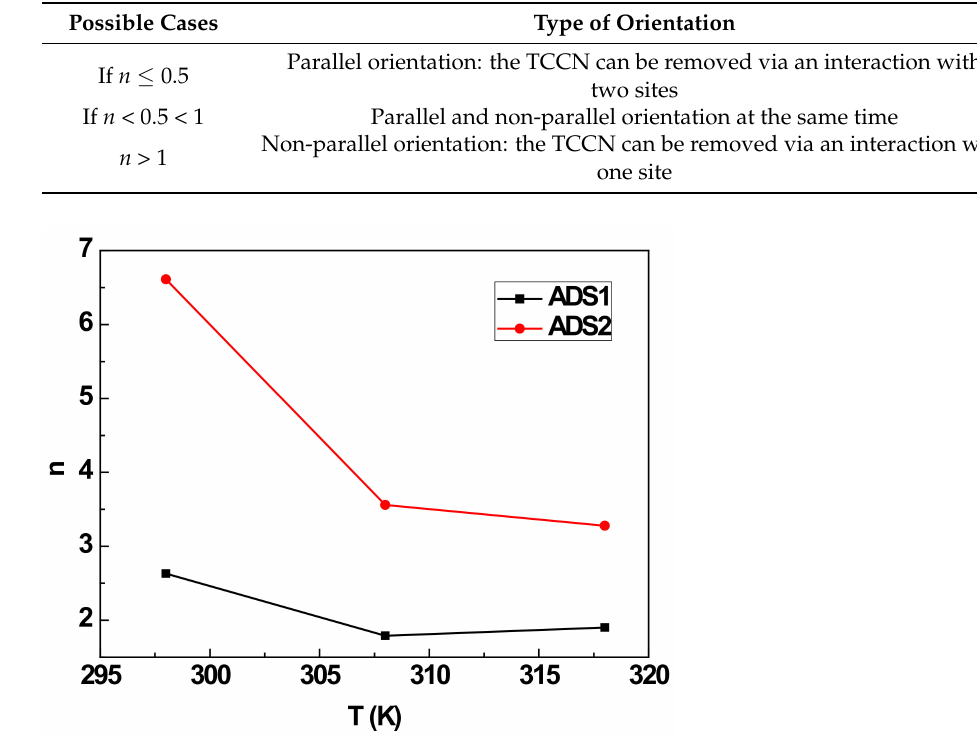
Figure 3. Impact of temperature on the parameter n .